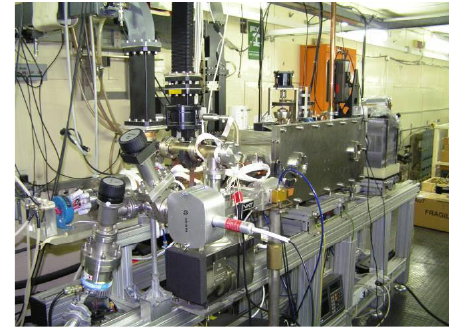
Fig. 2. The ENEA FEL-CATS source Beside FEL sources, our laboratory has been equipped with an extensive assortment of other coherent sources, both lasers and electron devices as a part of the Center of Excellence for Terahertz Radiation and Applications (CETRA). A Far InfraRed (FIR) gas laser based on a CO laser, pumping a gas 2 cell, is available as well as a Ti:Sa laser oscillator that generates a train ultra-short pulses (about 130 fs) in the Near InfraRed (NIR) with an average CW power in excess of 1W. Other compact, portable, solid state sources are available in the THz laboratory to cover the low frequency spectrum: two YIG oscillators that emit in the ranges 8-20 and 20-40 GHz respectively, with an average CW power of 5-10 mW; an IMPATT diode at 97 GHz with about 80 mW of output power and a second IMPATT diode emitting at 140 GHz with about 20 mW of power. Finally a frequency multiplier in the range 220-330 GHz is also available to test high frequency